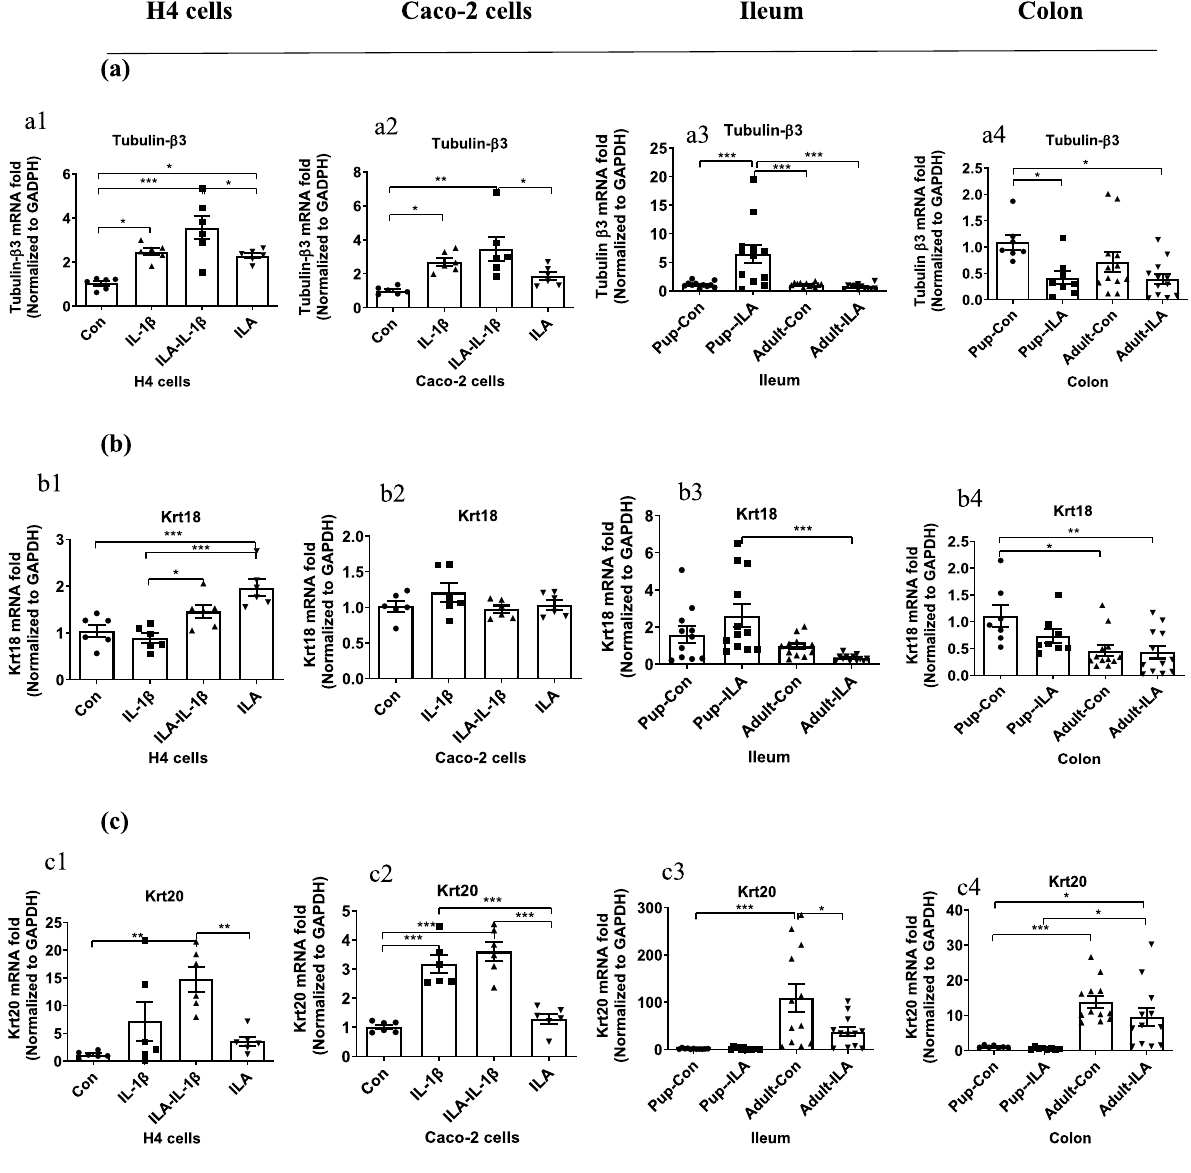
Figure 5. ILA regulated cell development/related gene expression in vitro and in vivo ( a ) Tubulin-β3 and ( b ) Krt18 (embryonic keratin), and ( c ) Krt20 (adult keratin) mRNA gene levels were determined by qRT PCR in H4 cells (a1, b1, and c1), Caco-2 cells (a2, b2, and c2), and ileum (a3, b3, and c3) and colon (a4, b4, and c4) of pups and adults. H4 or Caco-2 cells were pretreated with ILA before IL-1β stimulation. Pup or adult mice were fed with or without ILA. Data are represented as the mean ± SEM (n = 6 for cells and adult mice in repeated experiment, n = 11–12 for pup mice). One-way ANOVA and Tukey post hoc tests were used for statistical analysis. Differences were considered significant at * p < 0.05, ** p < 0.01, *** p <